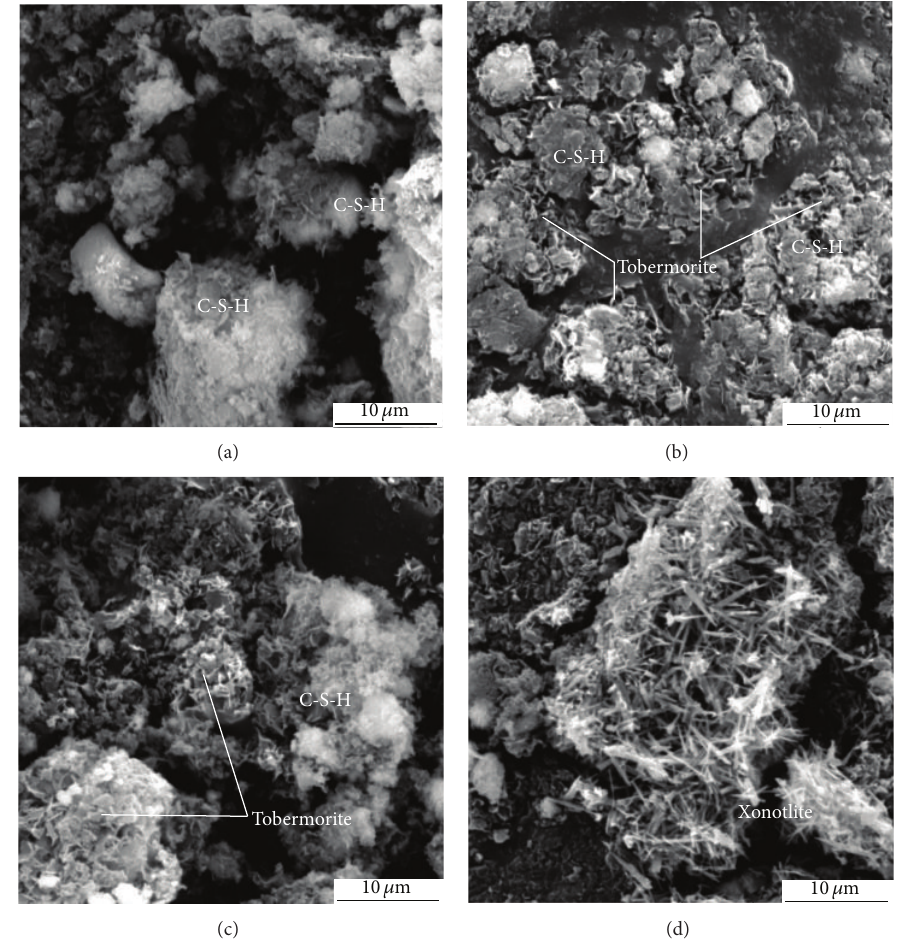
Figure 2: SEM micrographs of ((a), (b)) SCSH and ((c), (d)) NSCSH.